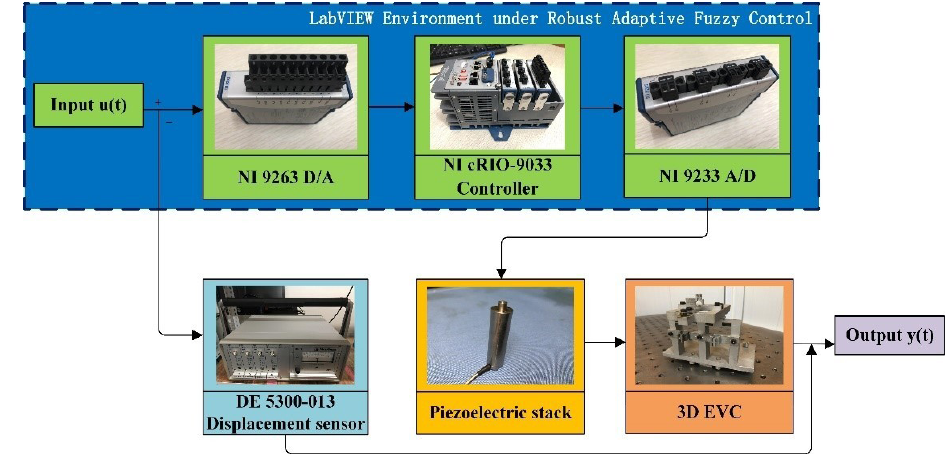
Figure 6. The 3D EVC closed-loop control system.